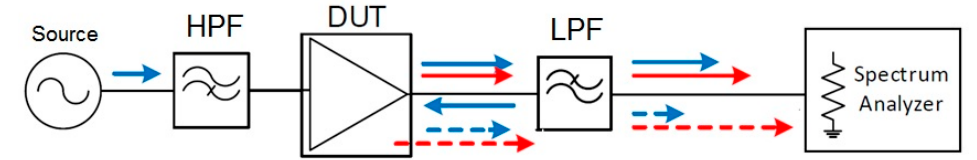
Figure 4. Measuring the second harmonic output of an amplifier with a reflective filter showing errors in the measurement setup.